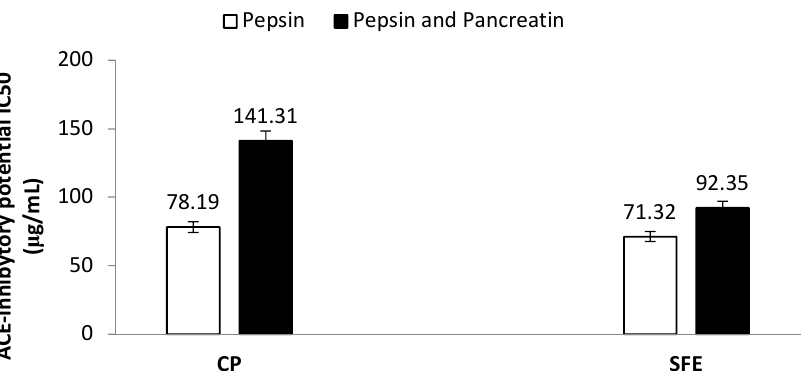
Figure 5. Comparison of Angiotensin-I Converting Enzyme (ACE) inhibitory potential of hydrolysates obtained after in vitro digestion of apricot oil cake protein isolates derived by cold pressing (CP) and supercritical fluid extraction (SFE). Values represent the mean ± standard deviation (SD) of n = 3 replicate analysis.